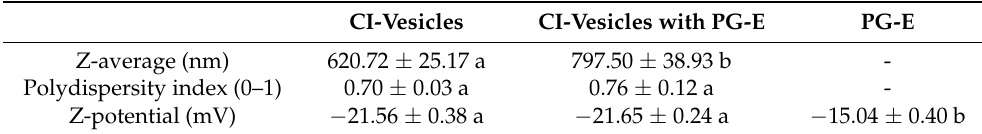
Table 2. Characteristics of CI-vesicles, CI-vesicles with PG-E, and PG-E: Particle Size, Polydispersity Index, and Zeta